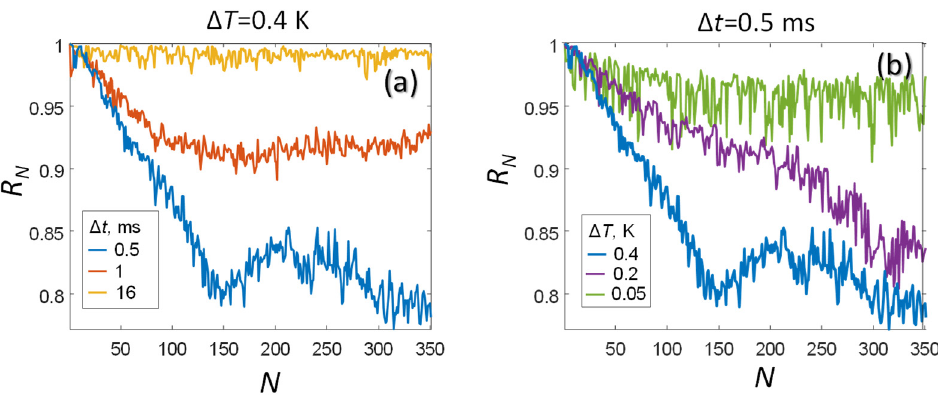
Figure 5. Temperature dependence of R N measured under various conditions of laser exposures characterized by Δ t and Δ T .